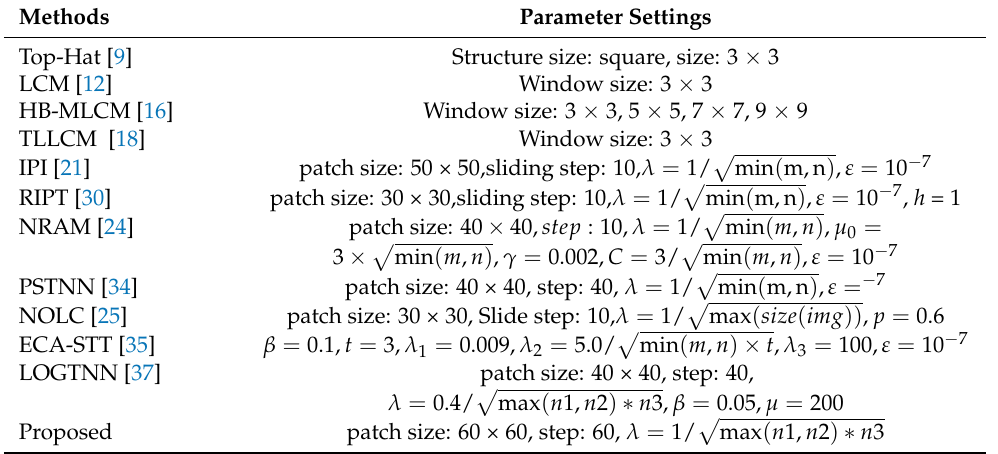
Table 3. Parameters of eleven state-of-the-art